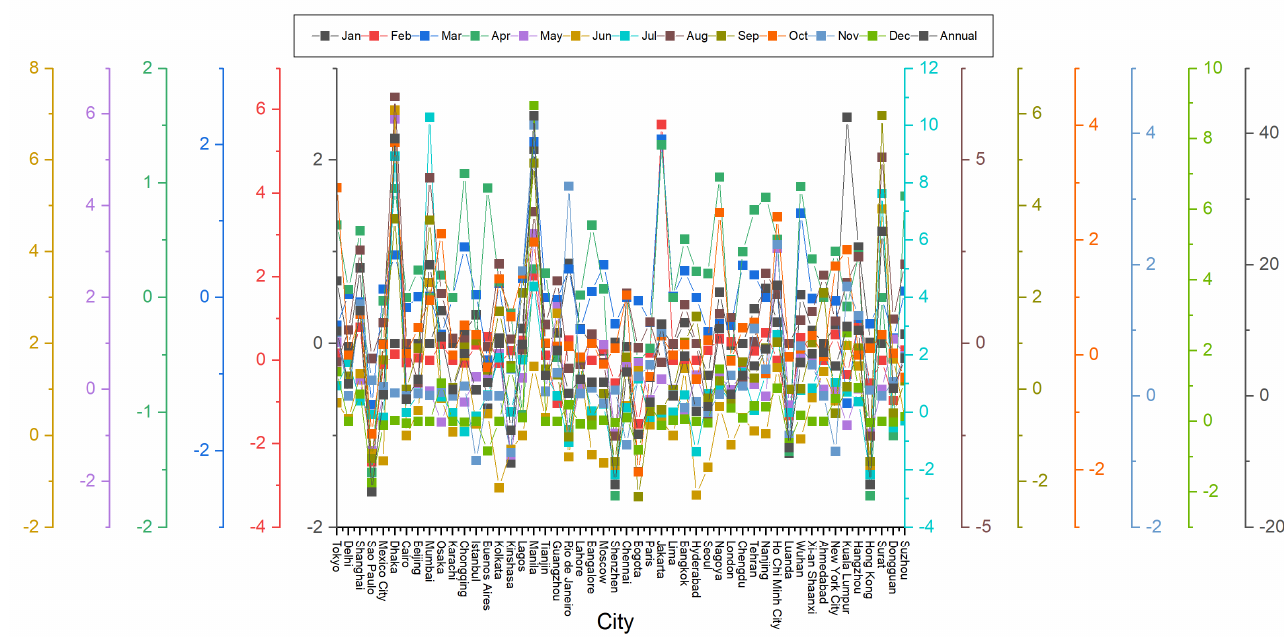
Figure 6. Monthly Variation of Sen’s Slope. (Red line showing the reference line at zero). In January, the Z statistics of precipitation data from Mann–Kendall for the 50 most populated metropolitan cities are displayed in Figure 7. According to a 95% significance threshold, the Z statistics are divided into four categories: Z > 1.96 as a significant positive trend, Z in between 1.96 and 0 as a positive trend, Z in between 0 and − 1.96 as a negative trend, and Z < − 1.96 as a significant negative trend. The data ranges from − 3.1464 (Luanda) to 2.7036 (Shanghai). Figure 7 shows the variation of Z statistics data from the Modified Mann–Kendall test, which varies from − 3.1464 (Luanda) to 3.0105 (Saudi Arabia) (Manila) shown in Table 2. The Monthly and annual Sen’s Slope Value from Modified Mann–Kendall Test are shown in Table